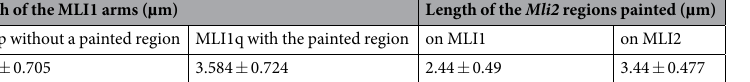
Table 1. Morphometry of the MLI1 arms with respect to the regions painted with Mli2 . The measurements were performed on 10 metaphase spreads and the reported values represent means ± 1